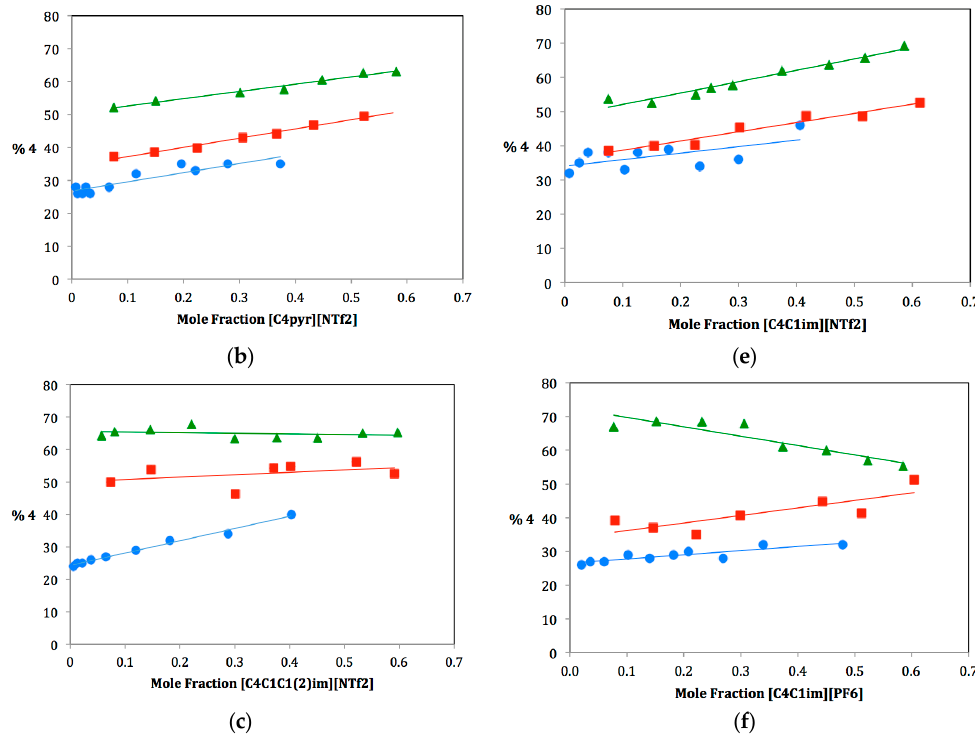
Figure 2. Plots of the percentage of elimination Product 4 vs. mole fraction of IL for methanol (•), ethanol ( ▪ ) and isopropanol ( ). Table 1. Rate of change of 4 with increasing mole fraction of IL for each dual-solvent system ( i.e. , slope (error)) and Kamlet–Taft (KT) solvatochromic parameters for each IL and protic solvent [17].